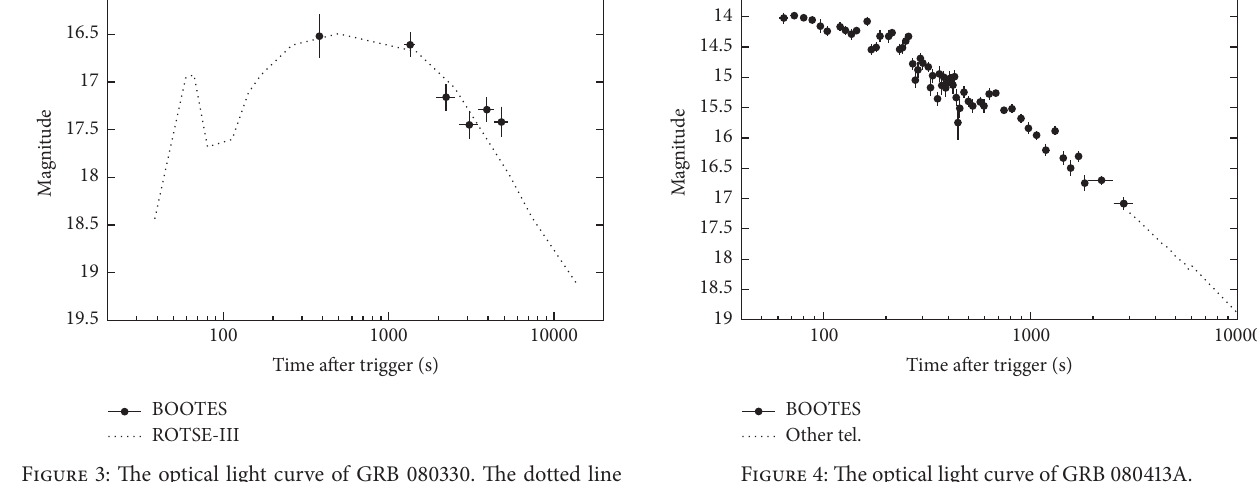
Figure 4: The optical light curve of GRB 080413A.